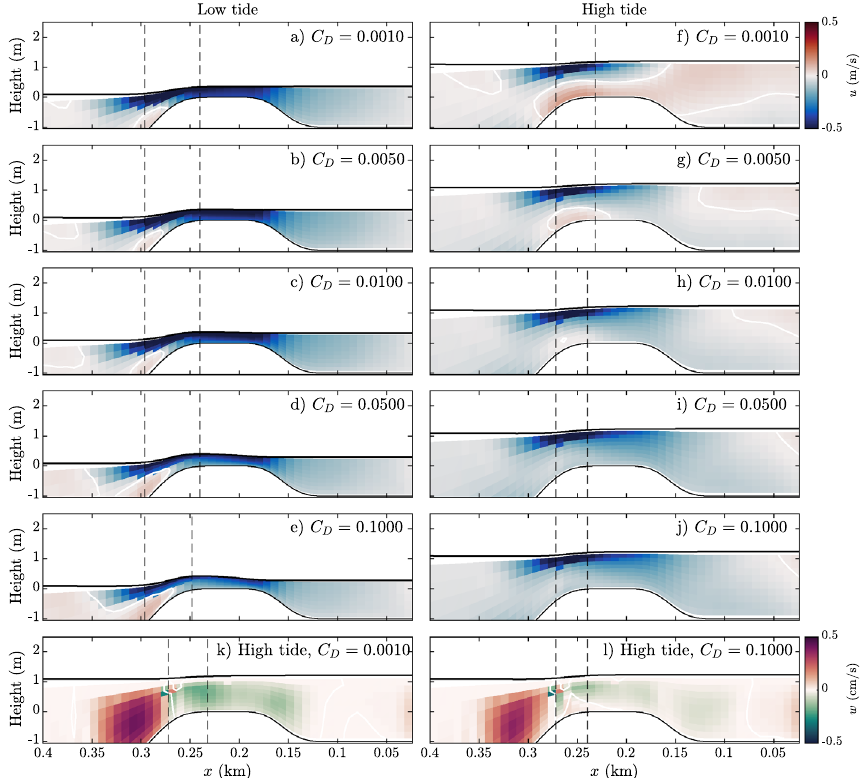
Figure 4. ( a–j ) Cross-reef Lagrangian velocity. Red indicates flow moving to the left, blue indicates flow moving to the right. The black, solid lines show the water level and bathymetry. ( k–l ) Vertical velocities on high tide for the models with the highest and lowest drag coefficients. Red colors indicate upward velocities and green colors indicate downward velocities. In all figures the vertical, dashed lines show where the majority of wave breaking takes